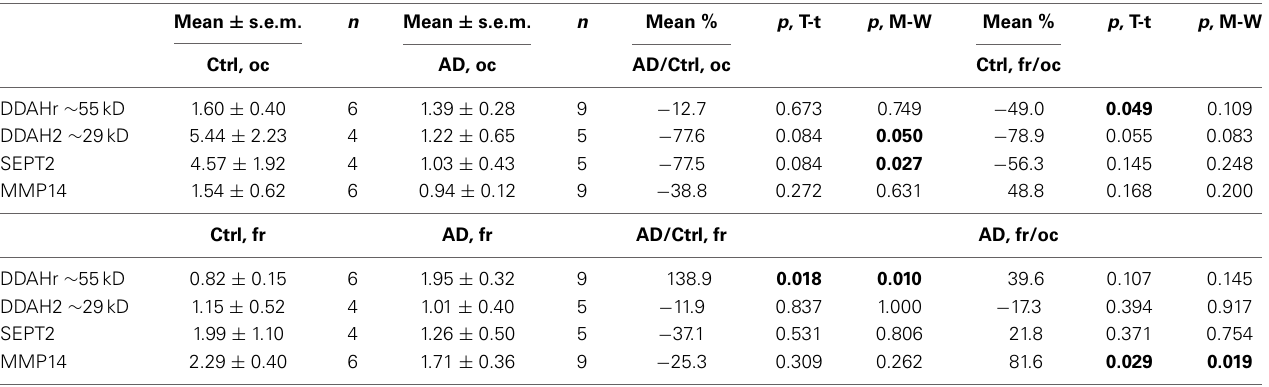
Table 5 | Expression level changes of the selected target proteins in occipital and frontal lobes of AD patients and healthy controls. Mean ± s.e.m. n Mean ± s.e.m. n Mean % p , T-t p , M-W Mean % p , T-t p , M-W Ctrl, oc AD, oc AD/Ctrl, oc Ctrl, fr/oc DDAHr ∼ 55kD 1.60 ± 0.40 6 1.39 ± 0.28 9 −